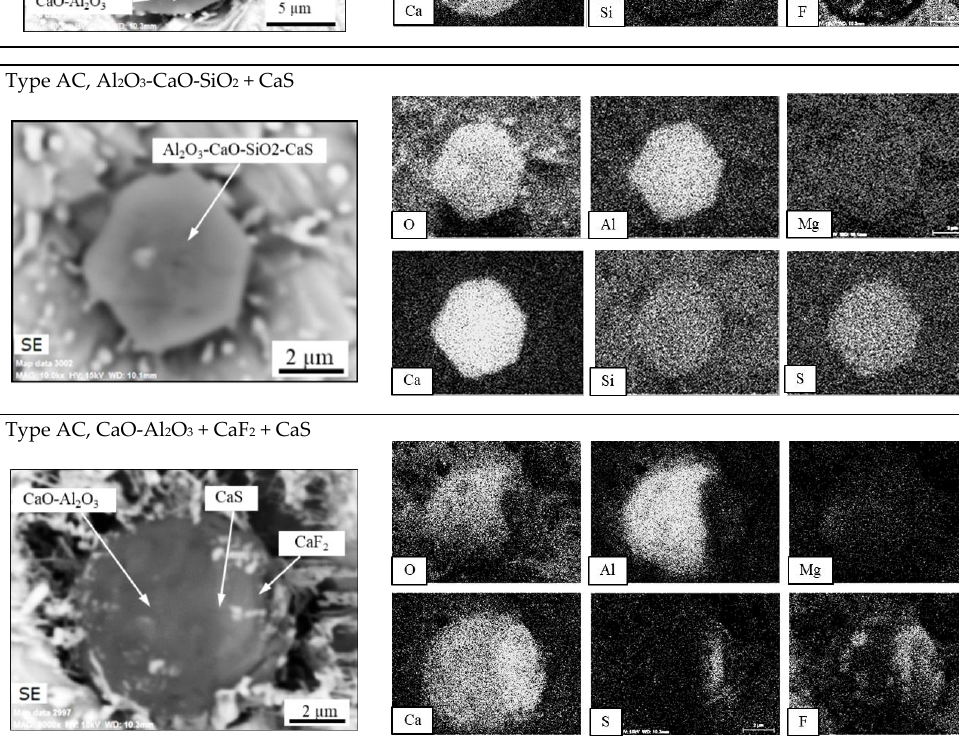
Figure 7. Mapping of main elements in different inclusions observed by three-dimensional (3-D) investigations on the surfaces of steel samples after electrolytic extraction.